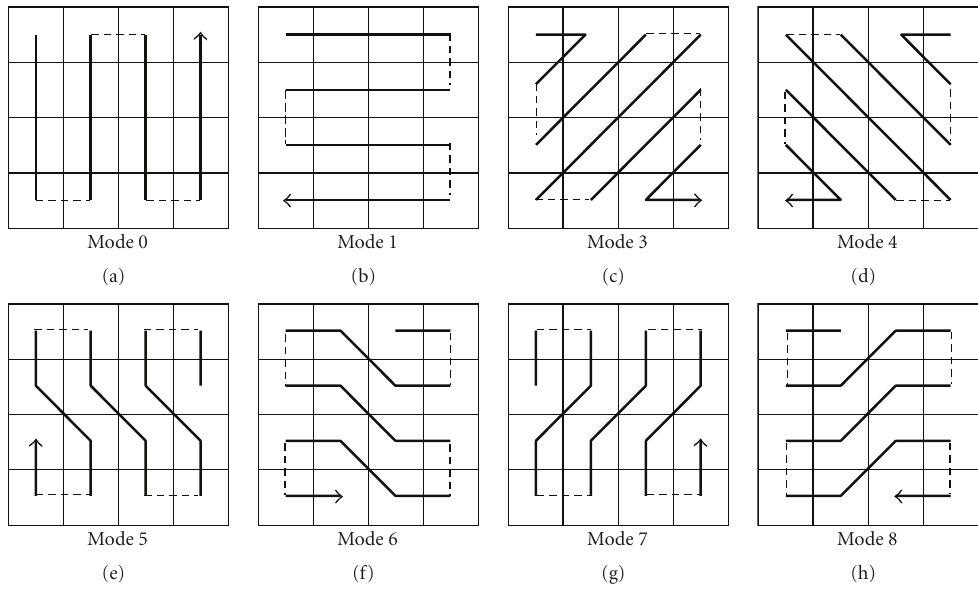
Figure 2: Eight scan modes for DPCM. Arrows indicate the scan order.